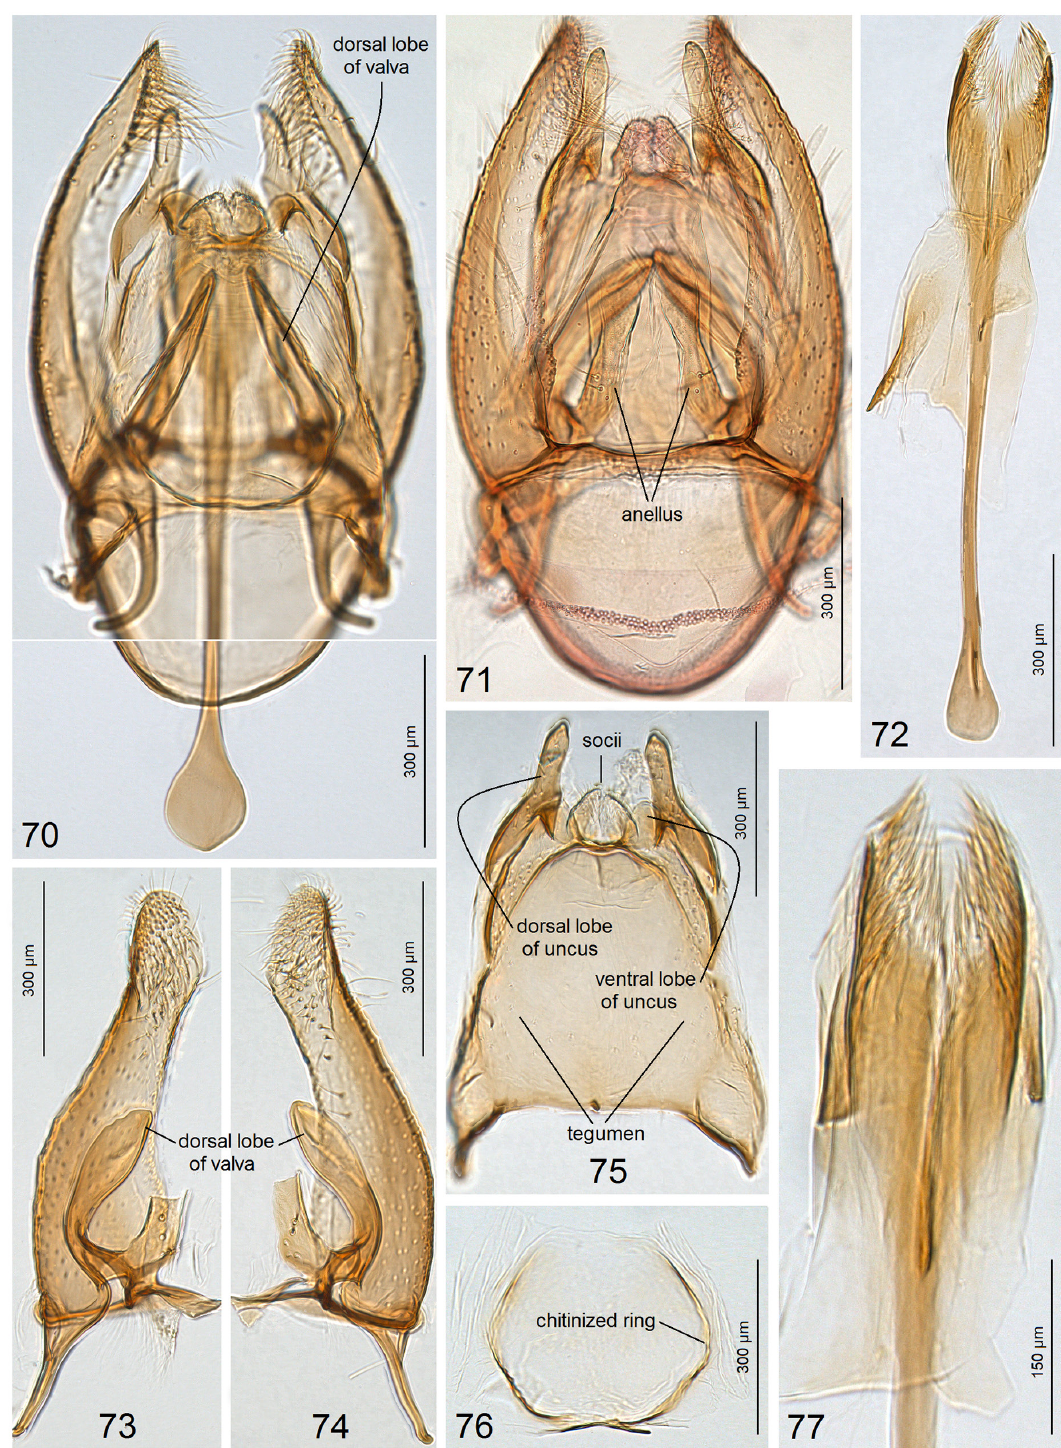
Figs 70–77. Male genitalia of Astrotischeria basilobata Remeikis & Stonis sp. nov. (NHMUK). 70 . Capsule, with phallus inside, holotype (genitalia slide no. 010316194). 71 . Capsule, with phallus removed, paratype (genitalia slide no. 010316198). 72 . Phallus, paratype (genitalia slide no. 010316196). 73–74 . Main element and dorsal lobe of valva, with anellus broken, paratype (genitalia slide no. 010316197). 75 . Same, uncus and tegumen. 76 . Same, chitinized ring of anellus. 77 . Same, apex of